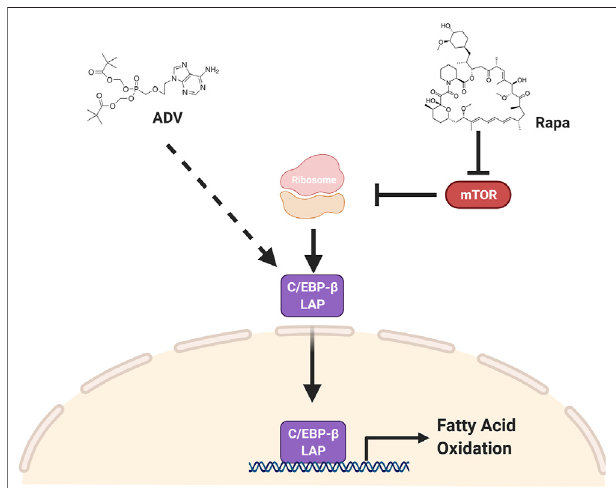
FIGURE 8 | C/EBP- β LAP is a druggable target to increase fat catabolism. Two pharmacological interventions, rapamycin and adefovir dipivoxil, converge on C/EBP- β LAP to enhance fatty acid oxidation and increase fatty acid catabolism, thereby protecting against obesogenic diets. Rapamycin increases the relative expression of C/EBP- β LAP by increasing its translation, while adefovir dipivoxil is acting through a yet to be determined